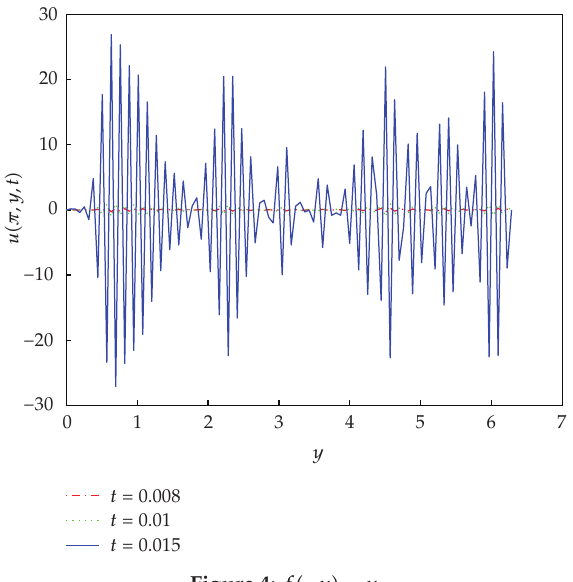
Figure 4: f (cid:6) · ,u (cid:7) (cid:5) u